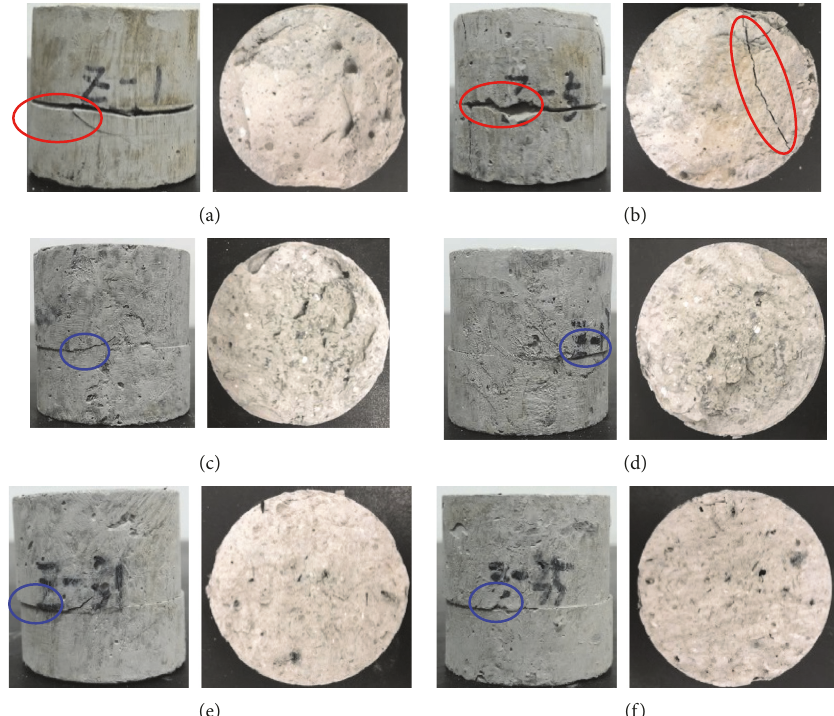
Figure 9: Failure modes of the specimens with different carbon fiber contents: (a) without carbon fiber; (b) without carbon fiber; (c) 0.25%; (d) 0.50%; (e) 0.75%; (f) 1.00%.